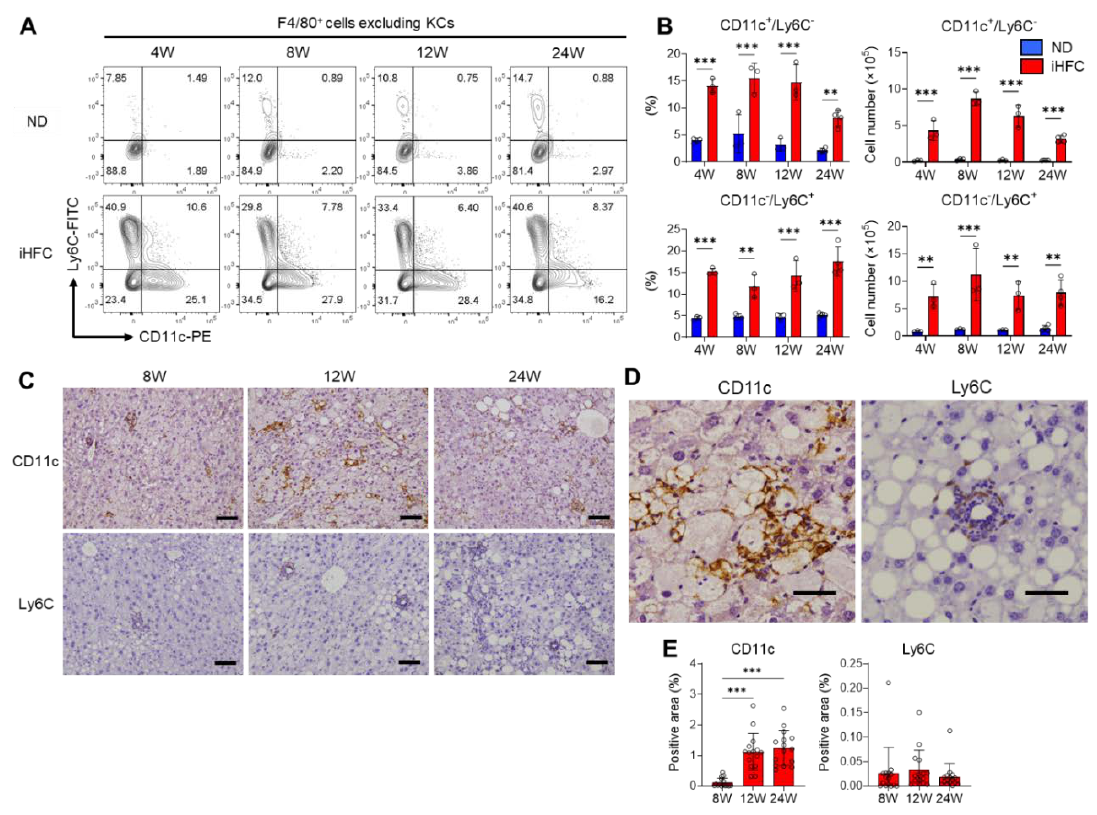
Figure 5. The iHFC diet accumulates two types of recruited macrophage subsets, CD11c + /Ly6C - and CD11c - /Ly6C + cells. ( A ) Representative flow cytometry data of CD11c and Ly6C expression on F4/80 + non-parenchymal cells excluding KCs of the livers from TSNO mice on the ND or iHFC diet for the indicated time periods. ( B ) Percentage and cell number of CD11c + /Ly6C - or CD11c - /Ly6C + were determined by flow cytometry analysis done in Figure 5A ( n = 3 or 4 per group). ( C ) Representative histological images of CD11c and Ly6C immunostaining of the livers from TSNO mice on the ND or iHFC diet for the indicated time periods. Scale bars, 100 µ m. ( D ) Representative magnified images of CD11c and Ly6C immunostaining of the livers from TSNO mice on the iHFC diet for 24 weeks. Scale bars, 50 µ m. ( E ) Positive areas for CD11c or Ly6C in the livers from TSNO mice on the iHFC diet for the indicated time periods were measured using ImageJ software. Data are shown as means ± SD. ** p < 0.01, *** p < 0.001. Statistical significance was evaluated by two-way ANOVA followed by post hoc Sidak